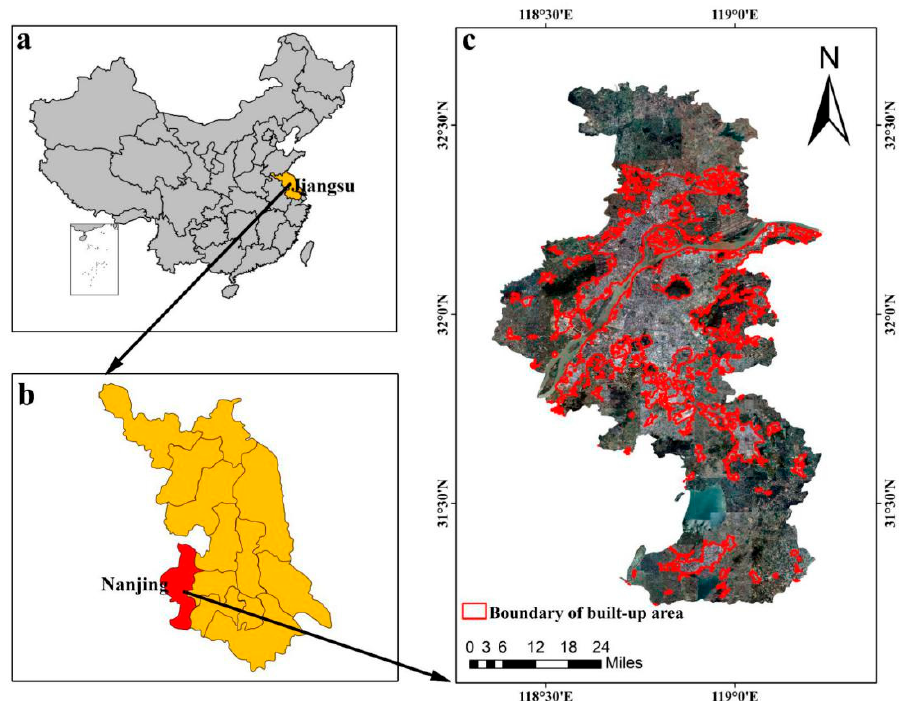
Figure 1. Location of the study area, ( a ) and ( b ) Jiangsu province, China, ( c ) the red polygons are the built-up area of Nanjing [12,30] with Sentinel-2A composite imagery as the background.